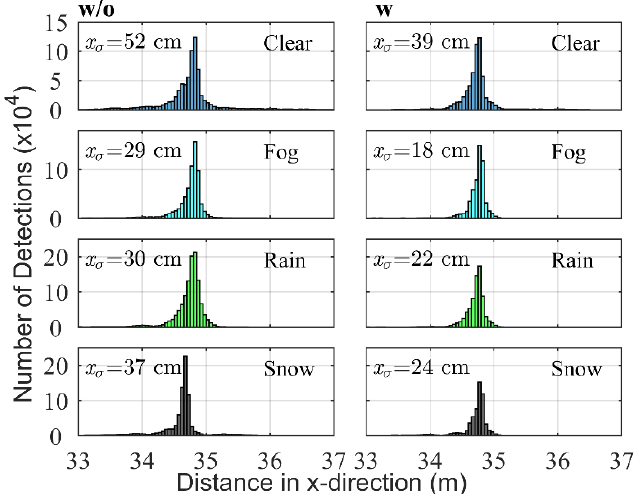
Figure 6. Distribution of the detections for each weather class (1900 frames each) in the street region: (w / o) without and (w) with background radiation. With x σ : standard deviation of the detection distance in x-direction in cm. Table 4. Most important parameters for the street region (33–37 m). (w / o) Without background radiation, (w) with background radiation. With n peak : number of detections in the maximum, x mean : mean detection distance, x σ : standard deviation of the detection distance, n e 2 : number of second echo detections and EPW : echo-pulse width. The results show mean value ± standard